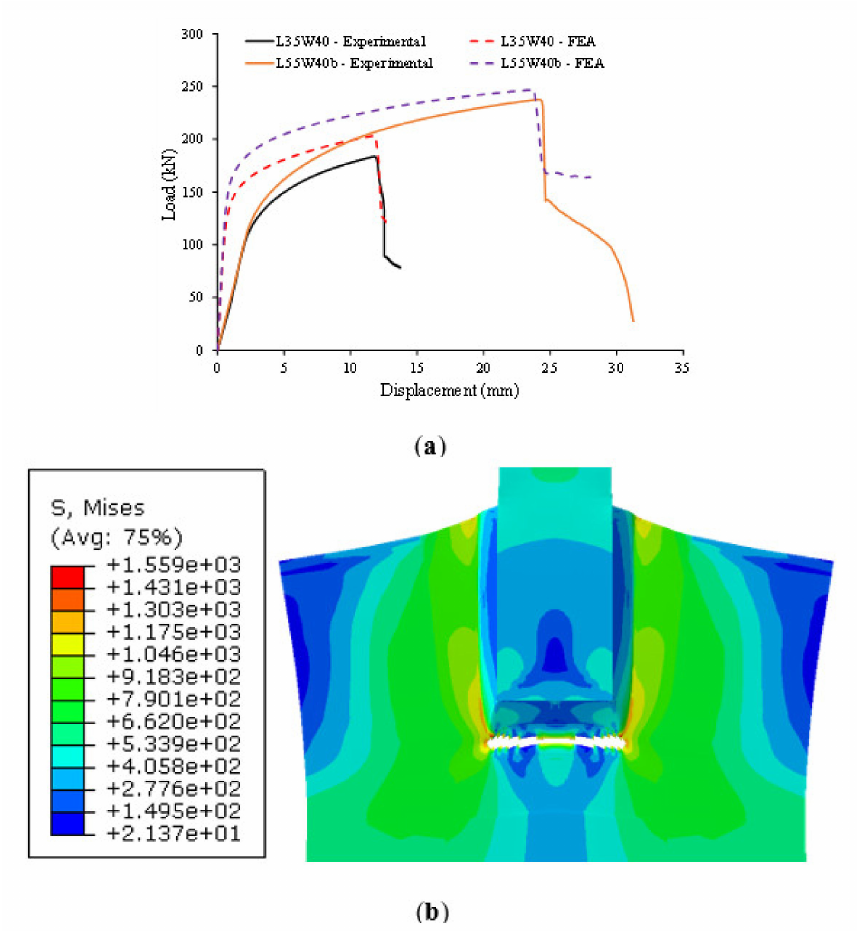
Figure 8. FE analysis results of fillet welded connections: ( a ) load–displacement curves; ( b ) simulated block shear